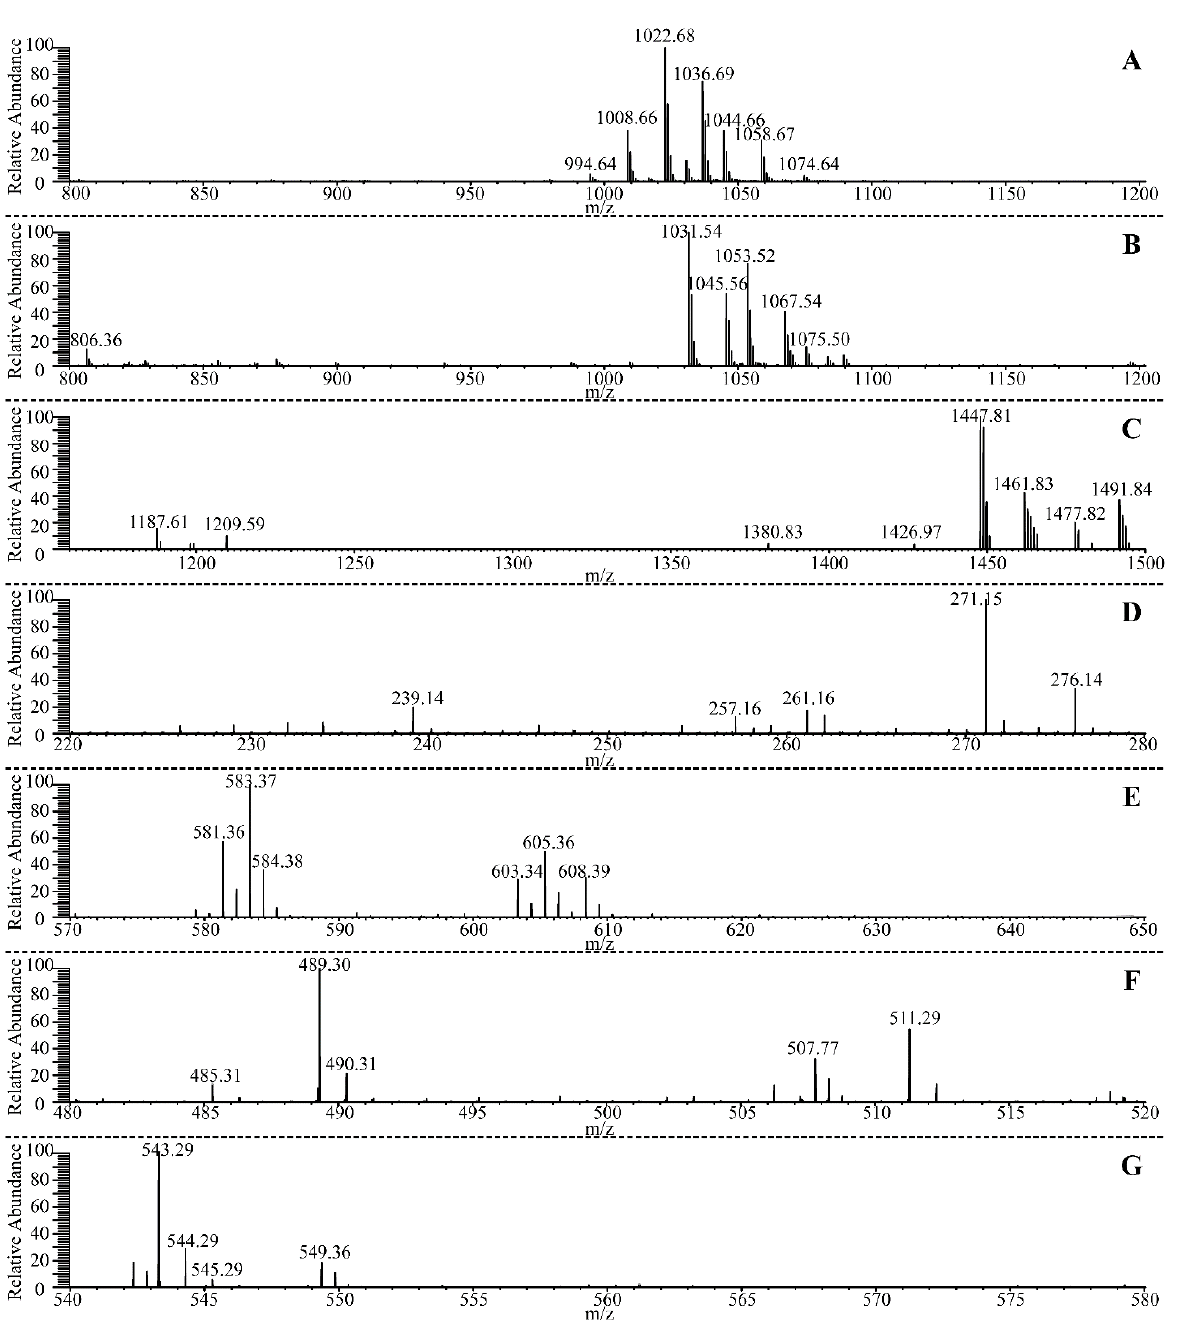
Figure 3. UHPLC-QE-MS analysis of secondary metabolites synthesized by B. velezensis ATR2. ( A ), Ions of m / z 994.64, 1008.66, 1022.68, and 1036.69 corresponded to the surfactin A (M + H) + , and ions of m / z 1044.66 and 1058.67 corresponded to surfactin A (M + Na) + ; ( B ), ions of m / z 1031.54 and 1045.56 corresponded to bacillomycin D (M + H) + , and ions of m / z 1053.52 and 1067.54 corresponded to bacillomycin D (M + Na) + ; ( C ), ions of m/z 1447.81, 1461.83, 1477.82, and 1491.84 corresponded to fengycin (M + H) + ; ( D ), ion of m / z 271.15 corresponded to bacilysin (M + H) + ; ( E ), ions of m / z 581.36 and 583.37 corresponded to bacillaene A (M + H) + and bacillaene B (M + H) + , respectively, and ions of m / z 603.34 and 605.36 corresponded to bacillaene A (M + Na) + and bacillaene B (M + Na) + , respectively; ( F ), ion of m / z 489.30 corresponded to 7- O -malonyl macrolactin A (M + H) + , and ion of m / z 511.29 corresponded to 7- O -malonyl macrolactin A (M + Na) + ; ( G ), Ion of m / z 543.29 corresponded to difficidin (M − H) −